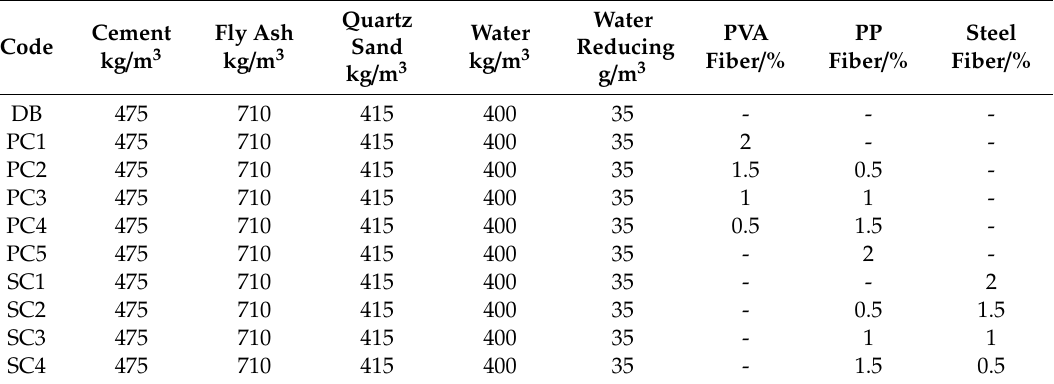
Table 1. Mix proportion of specimen.